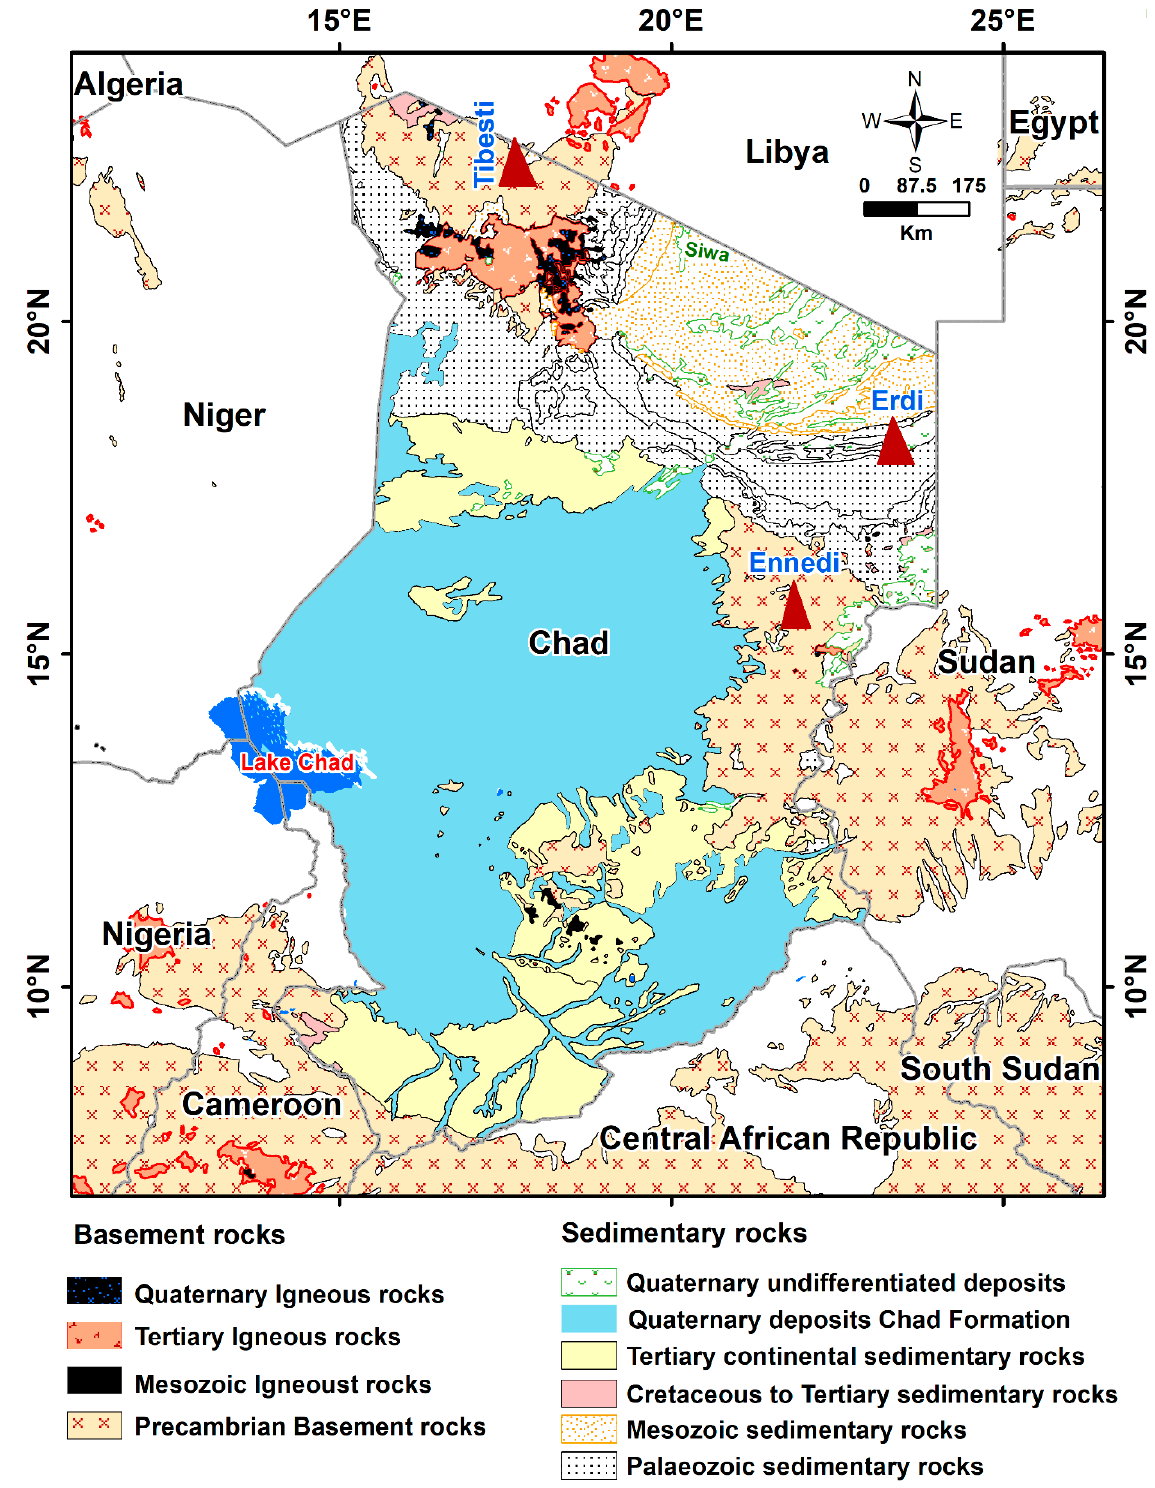
Figure 1. A geological map of the research area.